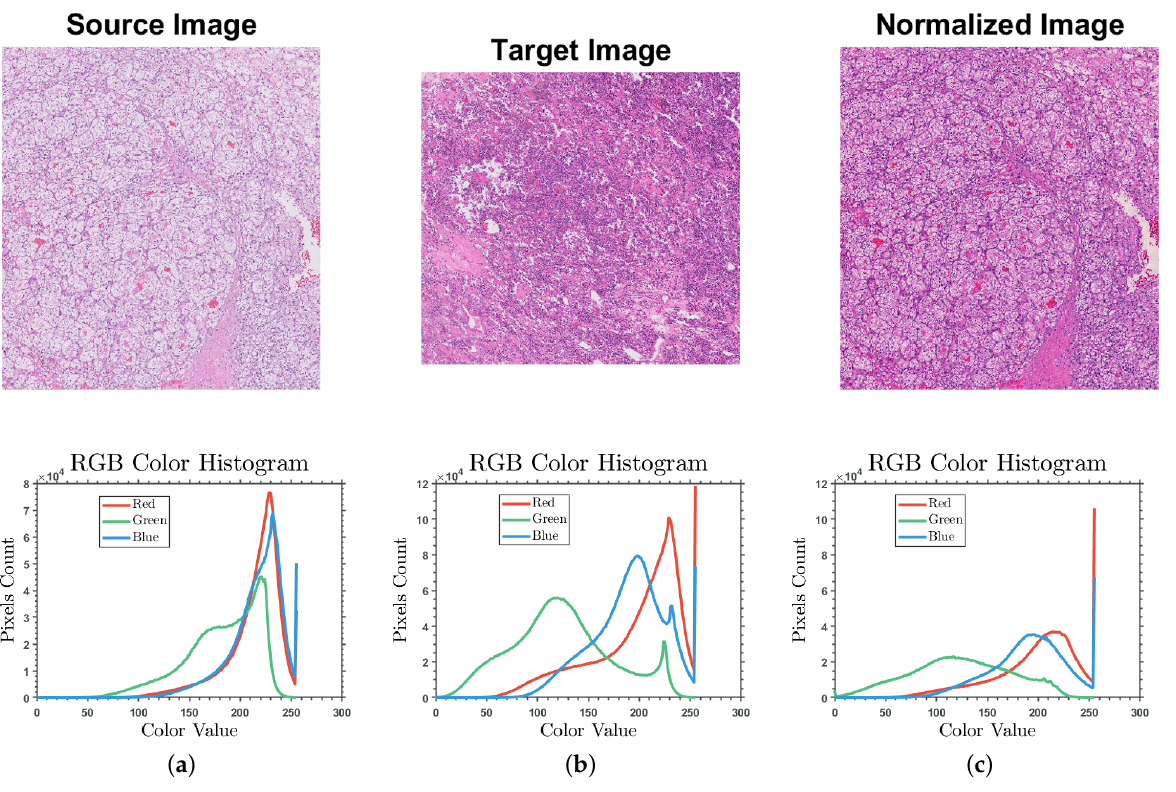
Figure 6. The stain normalization of a clear cell RCC sample ( a ) before color normalization; ( b ) the tar- get sample; and ( c ) after color